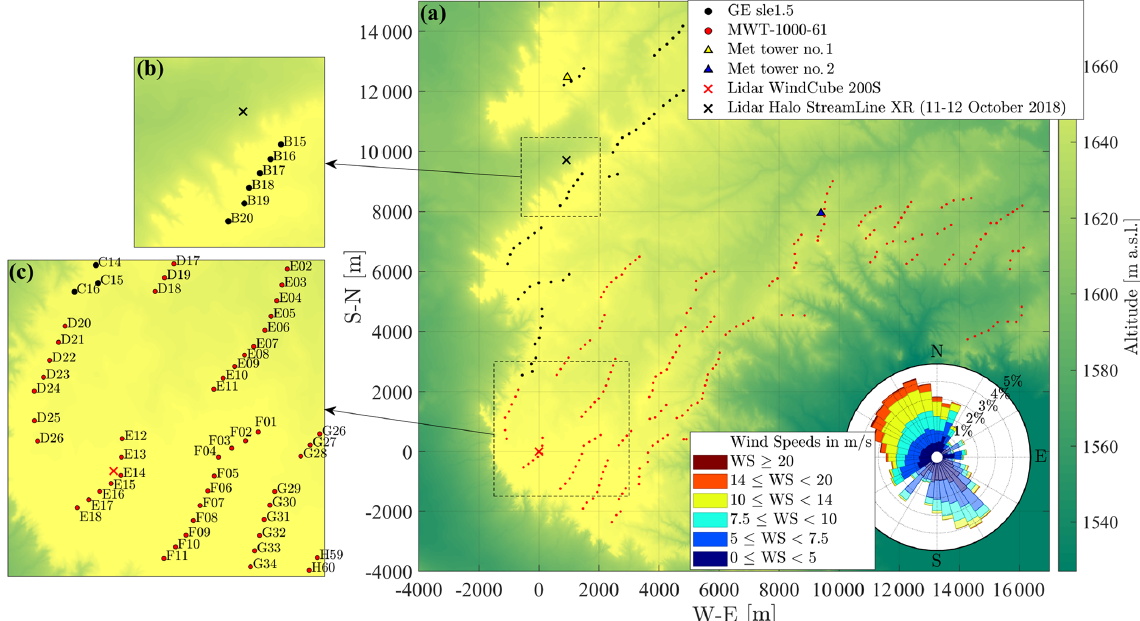
Figure 1. Map of the wind farm under investigation. (a) Top view of the wind farm, with the diameter of the dots representing the turbine rotor diameter (in the wind rose, the sectors where both meteorological (met) towers are potentially affected by turbine wakes are displayed in lighter color). (b) Area probed through StreamLine XR lidar on 11 and 12 October 2018. (c) Typical field of view of the WindCube 200S lidar. Table 1. Technical specifications of the wind turbines under investigation.